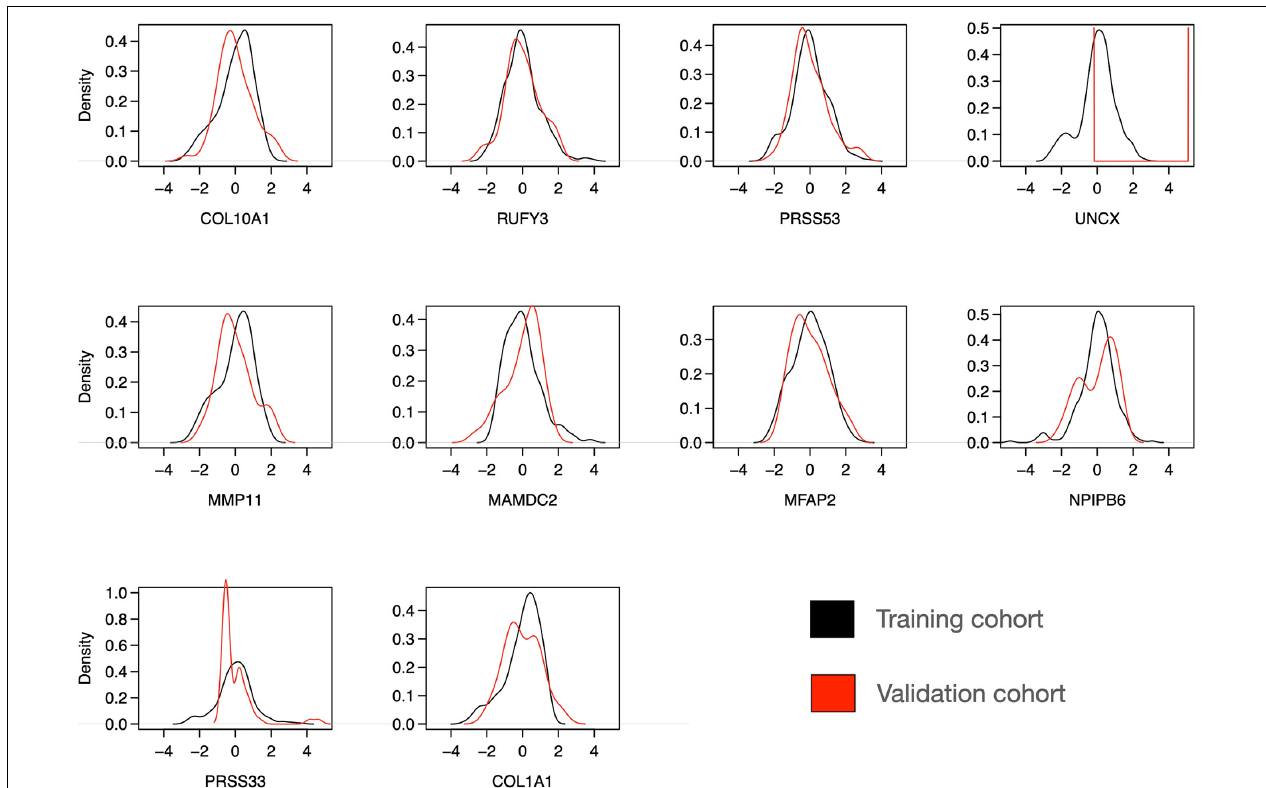
FIGURE 8 | Distribution of expression levels of 10 selected genes over all the individuals in the training and validation cohorts. The scales between the microarray (training cohort) and RNA-seq (validation cohort) data were harmonized using z-score normalization over each gene separately in the training and validation datasets. Note: the y-axis density ranges differ between the